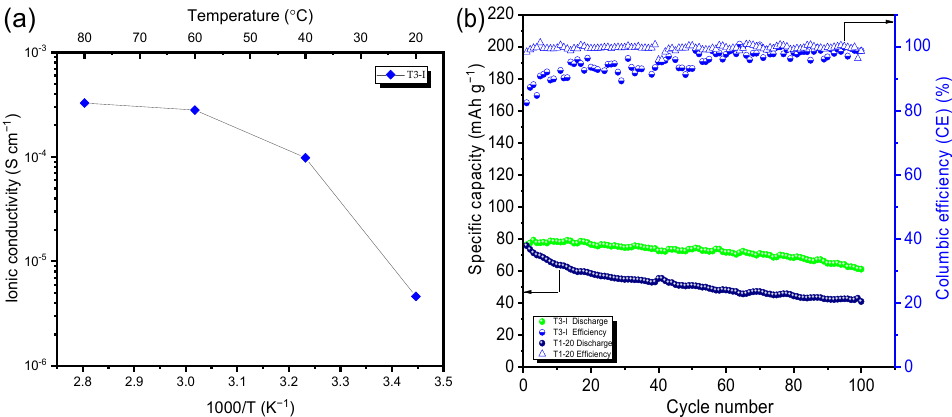
Figure 9. ( a ) Ionic conductivities for T3-I, ( b ) the discharge capacity and the Coulombic efficiency for the Li°|T3-I|LFP and Li°|T1-20|LFP at 80 °C (0.2 C).